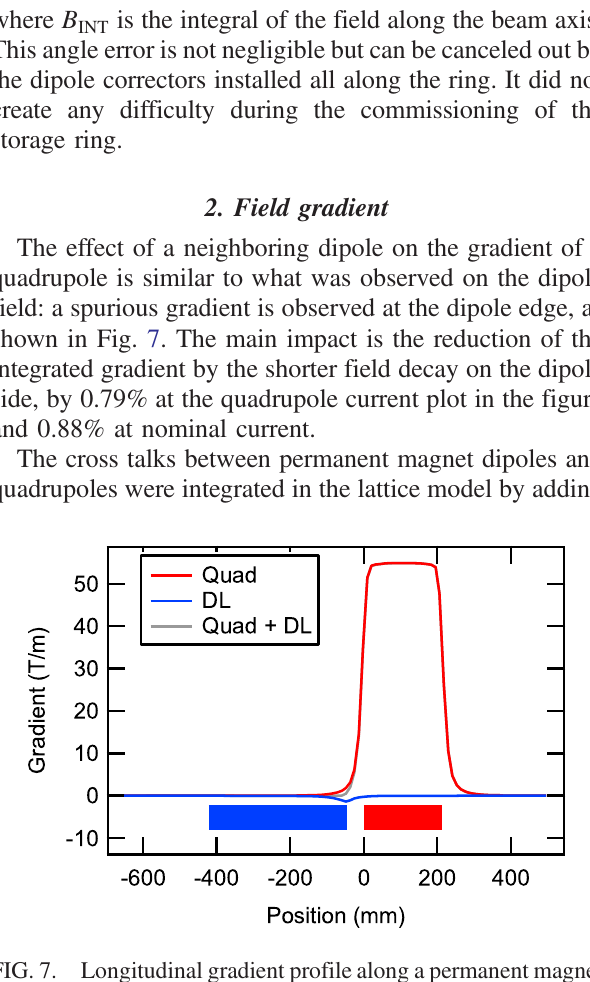
FIG. 7. Longitudinal gradient profile along a permanent magnet dipole (DL) and a moderate gradient quadrupole magnet. The cross talk induced gradient in the dipole can be modeled as a thin lens at the edge of the dipole, with opposite polarity. The quadrupole current was set to 94.5 A for this